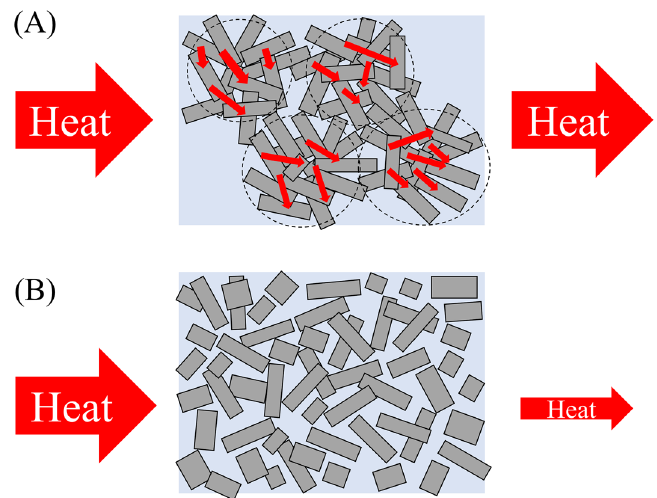
Figure 1. A correct version of the original Figure